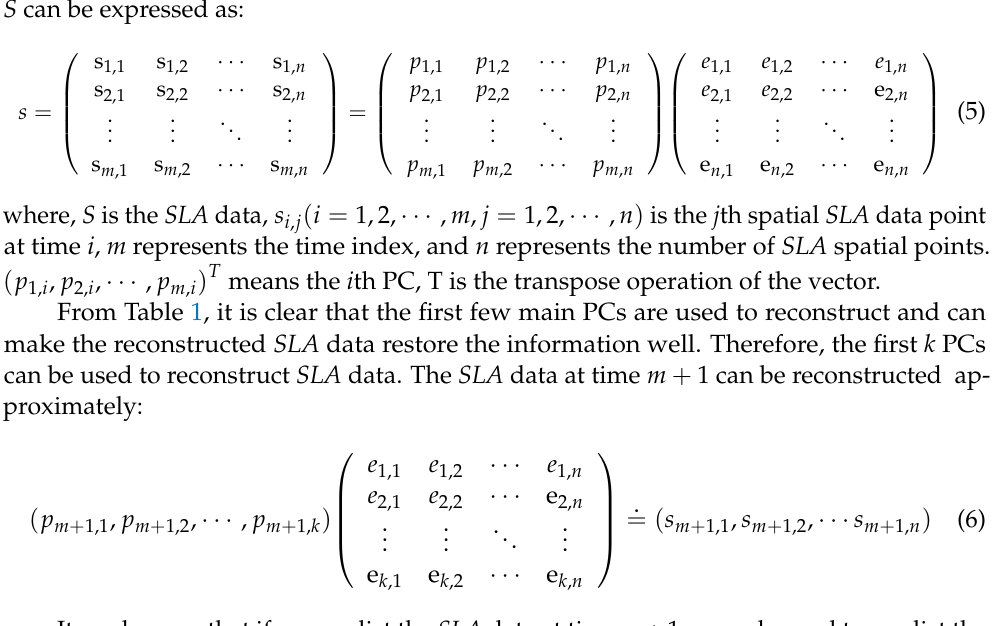
Figure 4. Overview of forecasting models. PC is the time-dependent principal component, PC i represents the observed PC of the i th time step, and ˆ PC i represents the predicted PC of the i th time step. EOF is the spatial mode.